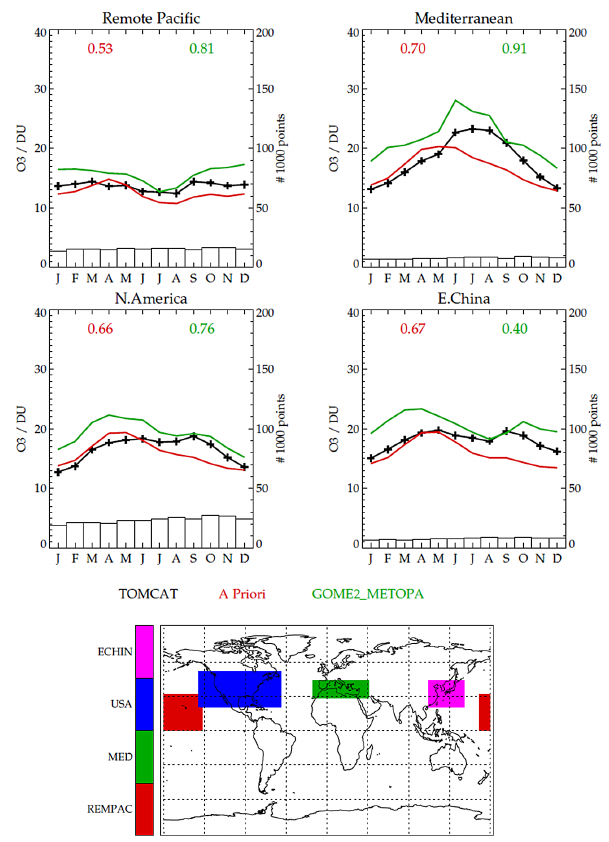
Figure 10. Time series comparison of surface to 450hPa ozone for four regions of TOMCAT (black), GOME-2 (green) and the GOME-2 retrieval a priori/climatology in 2008. Monthly correla- tion coefficient of TOMCAT and the a priori (red) and GOME-2 (green) are also given for each region. In all cases GOME-2 aver- aging kernels have been applied to TOMCAT. Bars and second axis indicate number of measurements in each month for each